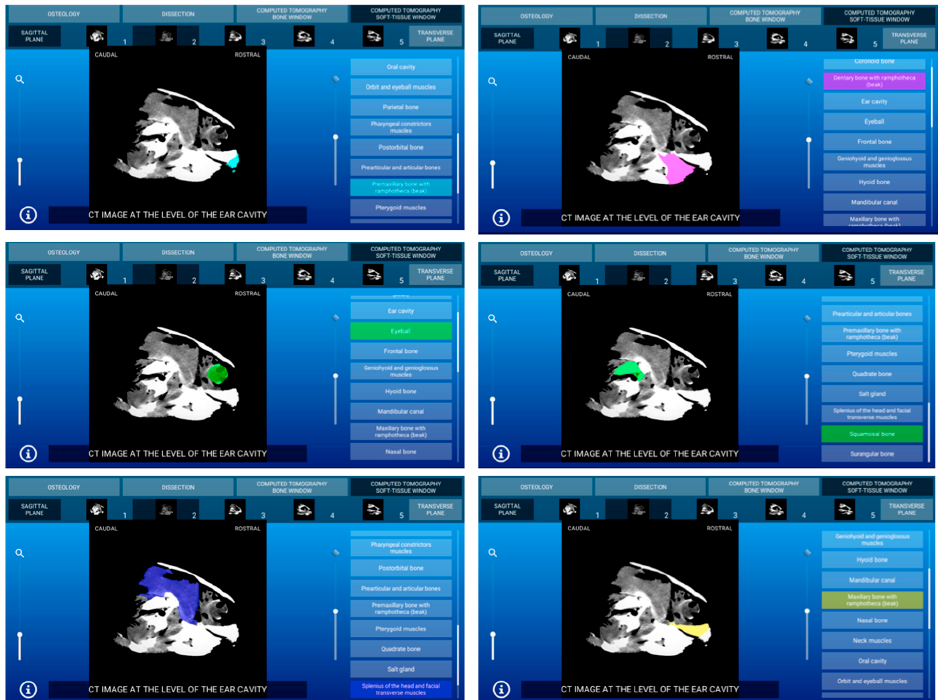
Figure 8. Atlas CT section: an interactive CT bone window transverse image at the level of the glot- tis is shown in caudal aspect.